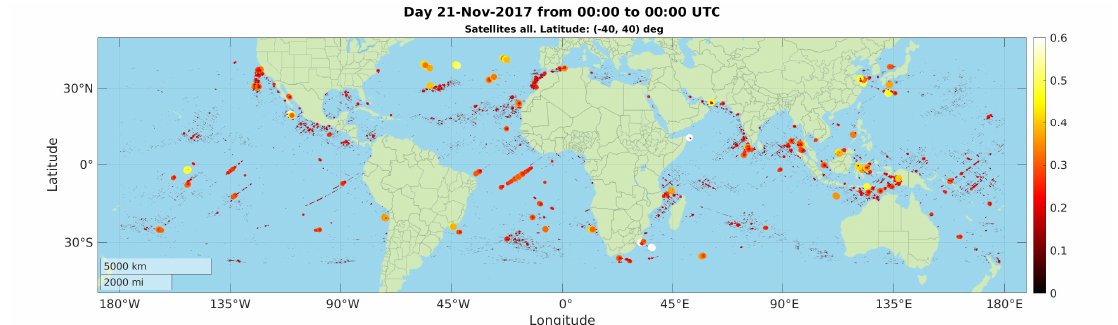
Figure 5. Computed and filtered S 4 values over all sea regions from 40 ◦ S to 40 ◦ N for 21 November